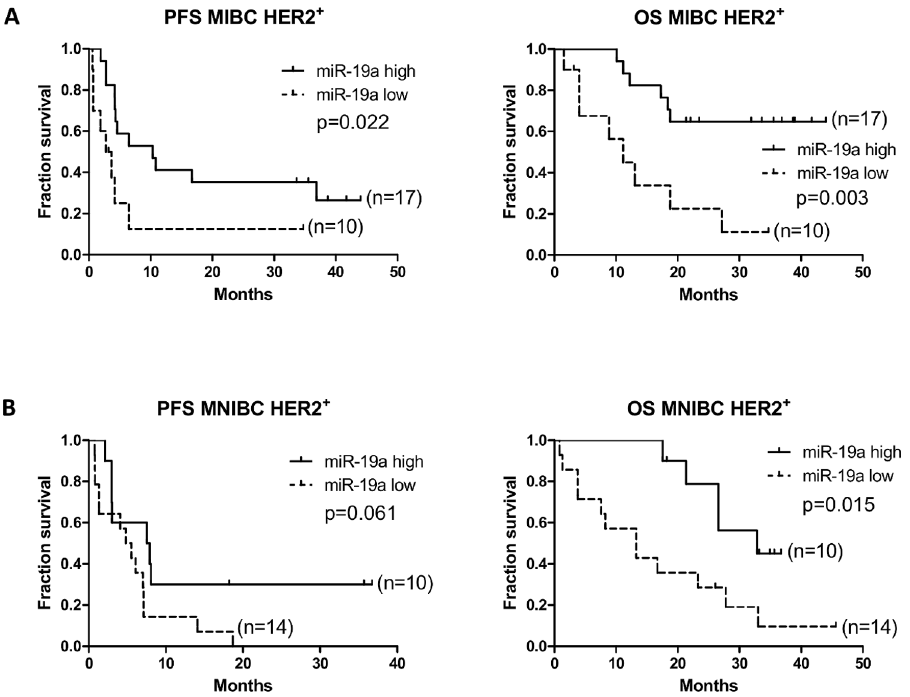
Figure 5. Kaplan-Meier plots of breast cancer patients according to serum miR-19a levels. The Kaplan-Meier plots show the survival time of breast cancer patients according to serum miR-19a levels. In a) patients with MIBC HER2 + and high serum miR-19a levels had longer PFS time (10.3 vs. 3.2 months; p=0.022) and OS time (median not reached vs. 11.2 months; p=0.003) than patients with MIBC HER2 + and with low serum miR-19a levels; in b) patients with MNIBC HER2 + and high serum miR-19a levels had longer PFS time (7.7 vs. 5.1 months; p=0.061) and OS time (32.9 vs. 13.3 months; p=0.015) than patients with MNIBC HER2 + and low serum miR-19a levels. High and low serum miR-19a levels were defined according to a cut-off corresponding to the mean values of miR-19a in the serum of HDs plus 2 standard deviations. A log-rank test was used to analyze the differences in the survival times between patients with high and low serum miR-19a levels. Characteristics of patients with MIBC HER2 + and high serum miR-19a levels: median age (48.3); trastuzumab-treated (12/17=70.6%); treatment-naı¨ve (3/17=17.6%); no trastuzumab-treated (2/17=11.8%). Characteristics of patients with MIBC HER2 + and low serum miR-19a levels: median age (53.2); trastuzumab-treated (5/10=50.0%); treatment-naı¨ve (0/10=0.0%); no trastuzumab-treated (5/10=50.0%). Characteristics of patients with MNIBC HER2 + and high serum miR-19a levels: median age (53.8); trastuzumab-treated (5/10=50.0%); treatment-naı¨ve (2/10=20.0%), no trastuzumab-treated (3/10=30.0%). Characteristics of patients with MNIBC HER2 + and low serum miR-19a levels: median age (54.1); trastuzumab-treated (11/14=78.6%); treatment-naı¨ve (1/14=7.1%); no trastuzumab-treated (2/14=14.3%).